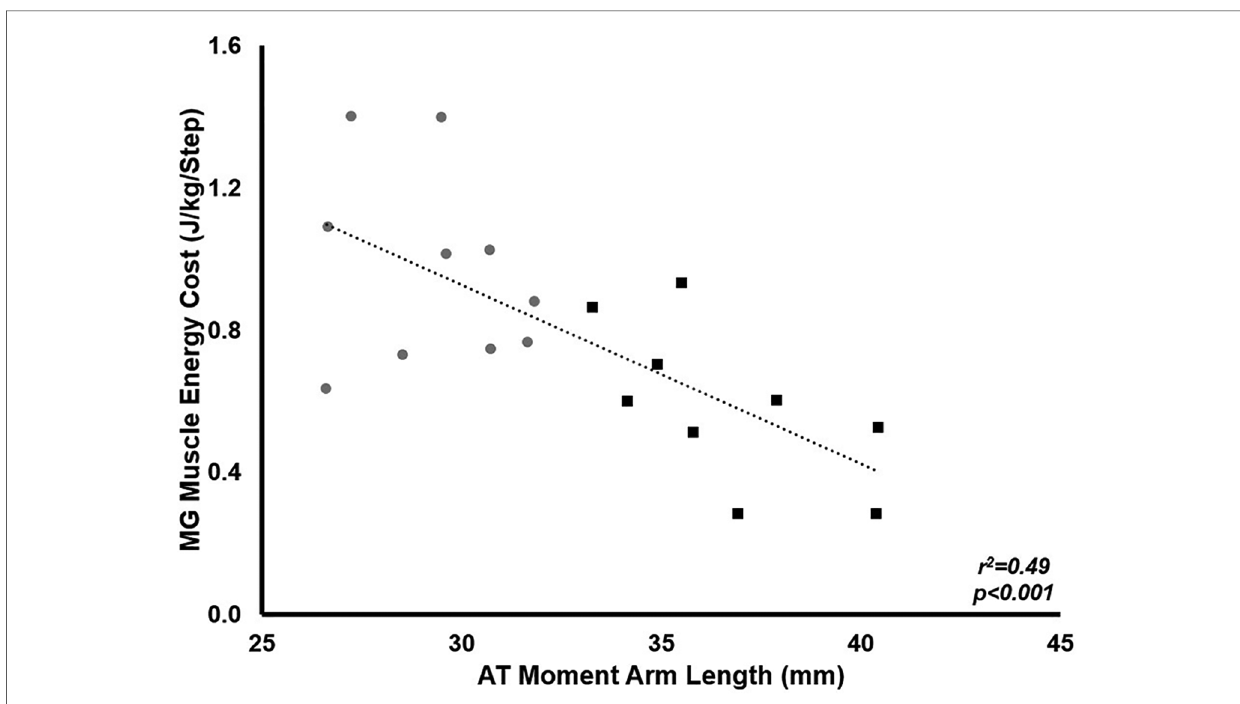
FIGURE 9 The relationship between MG muscle energy cost during stance and AT MA . Grey circles represent the SHORT AT MA group, while black squares represent the LONG AT MA group. Across all participants, a longer AT MA was associated with a lower muscle energy cost during